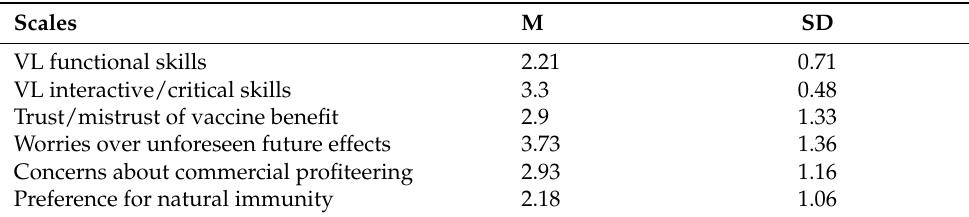
Table 3. Mean and standard deviation for the analysis of skills, perceptions, attitudes and beliefs toward COVID-19 vaccinations.